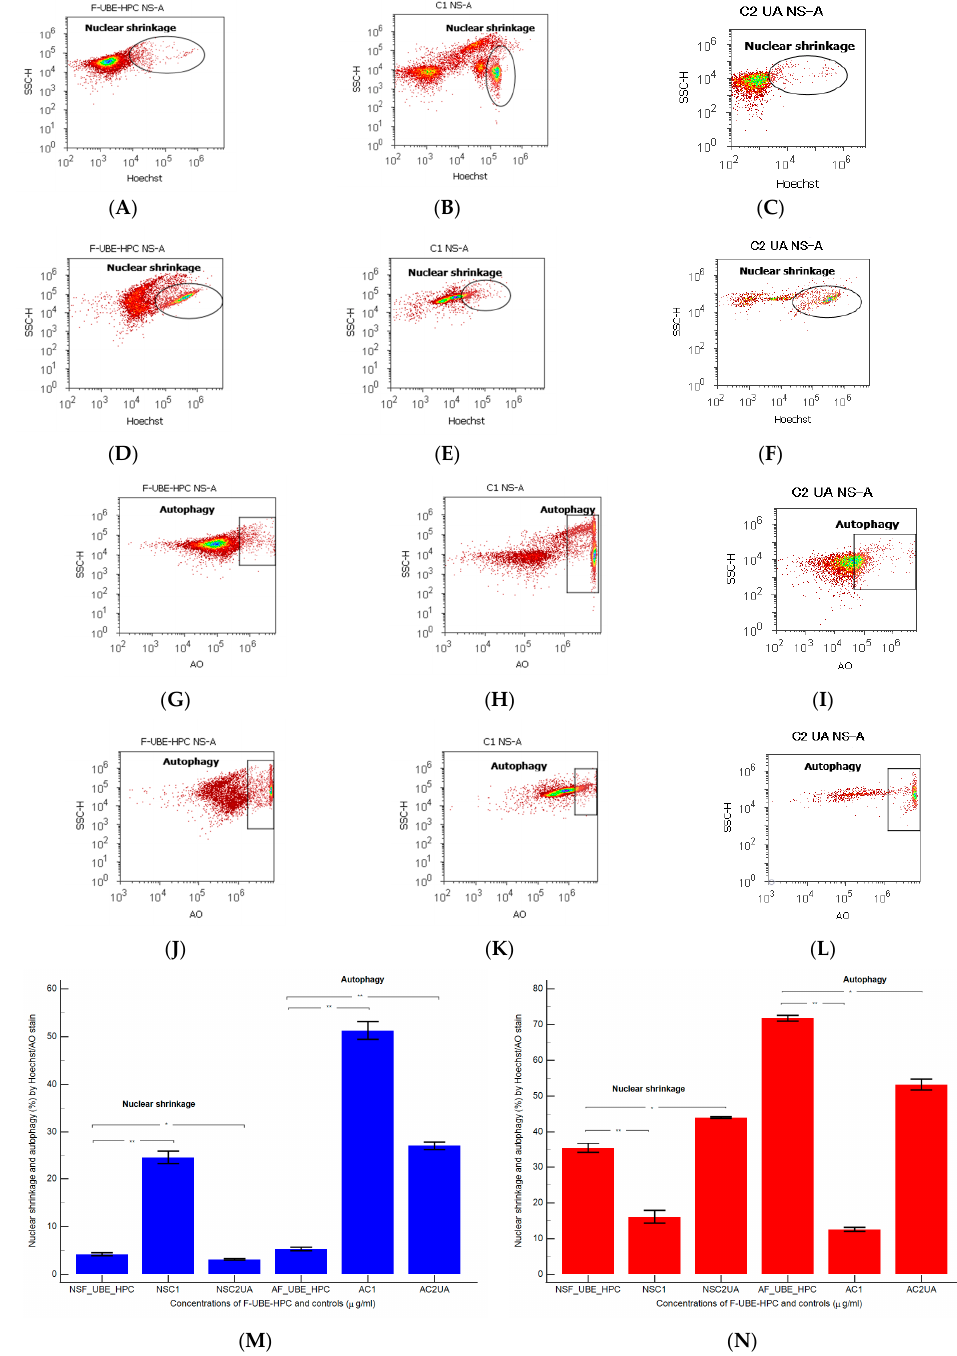
Figure 10. Nuclear shrinkage ( A – F ) and Lysosomal activity ( G – L ) after 24 h treatment with F-UBE-HPC in normal blood cells ( A – C , G – I ) and CLS-354 tumor cells ( D – F , J – L ). Hoechst patterns of F-UBE-HPC ( A , D ); 1% DMSO negative control (B, E); 125 µg/mL UA positive control ( C , F ); acridine orange patterns of F-UBE-HPC ( G , J ); 1% DMSO negative control ( H , K ); 125 µg/mL UA positive control ( I , L ). Statistical analysis of nuclear shrinkage and autophagy ( M , N ) in normal blood cell cultures ( M ) and CLS-354 tumor cell line ( N ). * p < 0.05 and ** p < 0.01 represent significant statistical differences between controls and sample made by paired samples t -test; NS—nuclear shrinkage; A—autophagy; C1—negative control with 1% dimethyl sulfoxide (DMSO); C2UA—positive control with 125 µg/mL usnic acid (UA); F-UBE-HPC—bioadhesive oral film loaded with U. barbata dry ethanol extract. Nuclear shrinkage, after 24 h treatment with F-UBE-HPC in normal blood cell cul- tures had significantly lower values (4.23 ± 0.58) than 1% DMSO negative control: 24.50 ± 2.21, p < 0.01 (Figure 10A,B,M), and appreciably higher than 125 µg/mL UA positive con- trol: 3.19 ± 0.30, p < 0.05 (Figure 10A,C,M). The autophagy levels strongly decreased com- pared with both controls: 5.36 ± 0.65; vs. C1: 51.30 ± 3.25; C2UA: 27.05 ± 1.52, p < 0.01 (Figure 10G–I,M). Flow-cytometry examination by Hoechst 33342/acridine orange dual stain of tumor cells after F-UBE-HPC treatment showed chromatin condensation (NS) and autophagy (A) significant elevation compared with 1% DMSO negative control: NS: 35.36 ± 2.28 vs. 16.11 ± 3.11; A: 71.81 ± 1.47 vs. 12.57 ± 0.92, p < 0.01; Figure 10D,E,J,K,M).